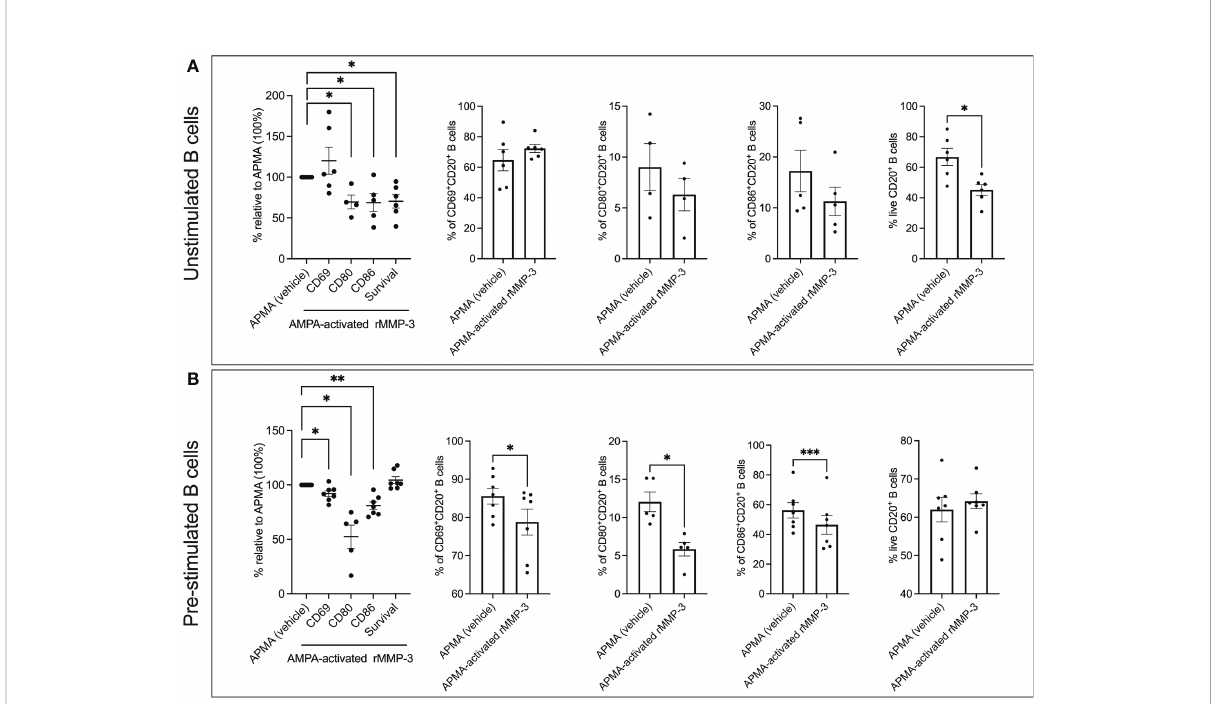
FIGURE 3 Analysis of activation markers and survival of B cells after MMP-3 stimulation. (A) Expression of CD69, CD80 and CD86 and viability of unstimulated (cells isolated from n = 4 – 6 healthy donors) B cells after treatment with APMA-activated rMMP-3 compared to APMA (vehicle) only. (B) Expression of CD69, CD80 and CD86 and viability of pre-stimulated (cells isolated from n = 5-7 healthy donors) B cells incubated with APMA-activated rMMP3 or APMA (vehicle) only. Relative expression of CD69, CD80 and CD86 and viability of either unstimulated (A) or pre- stimulated B cells (B) after treatment with rMMP-3 compared to vehicle is also shown. Graphs show mean values + SEM. * p < 0.05, ** p < 0.01, *** p < 0.001; paired t test, Wilcoxon test. APMA, 4-aminophenylmercuric